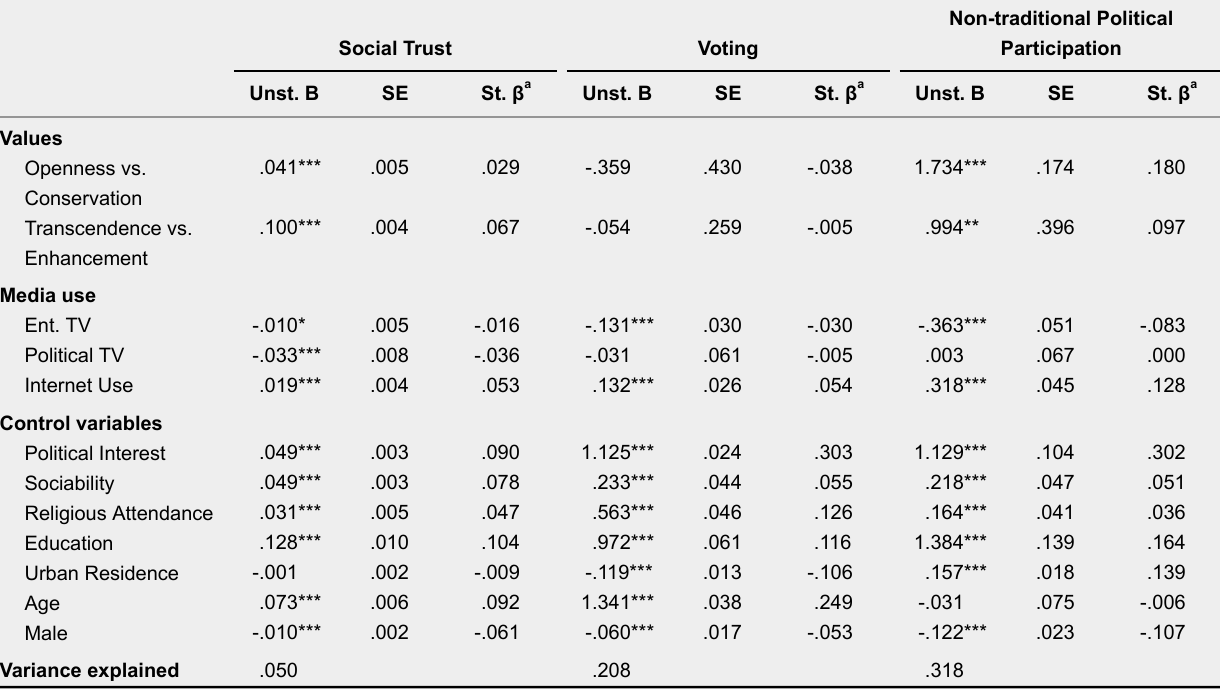
Estimated Effects of Values in Within-Level Civic Engagement Equations (N = 37,704)